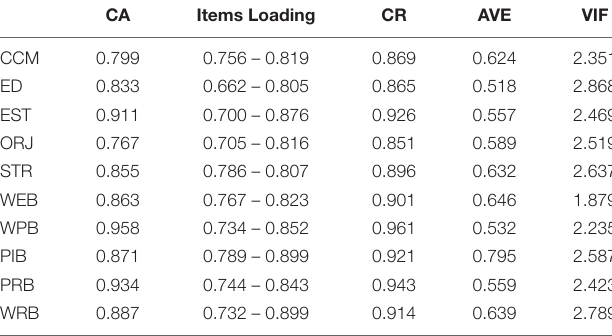
TABLE 1 | Summary statistics of the measurement